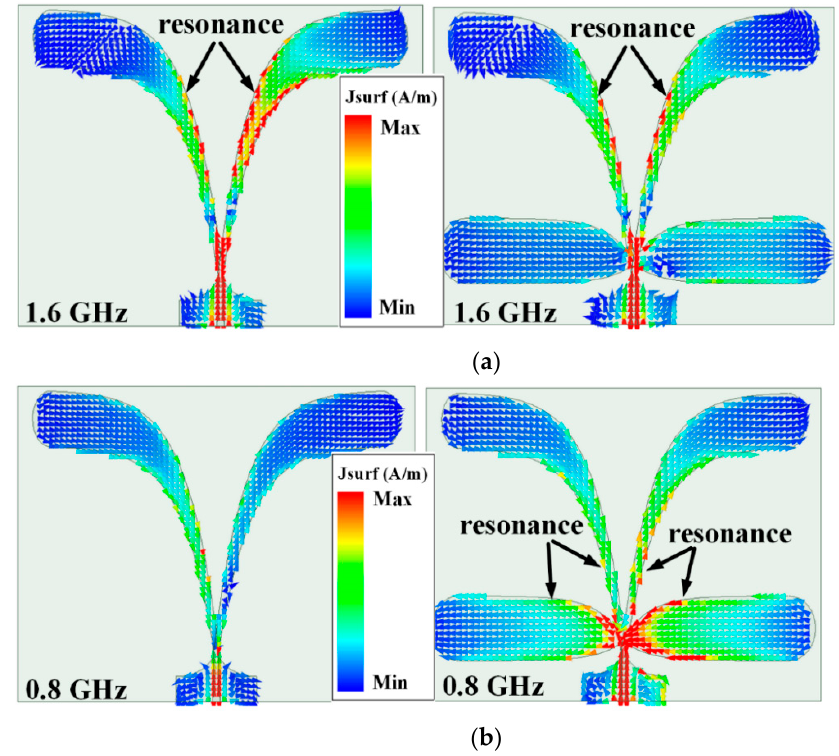
Figure 3. ( a ) Surface current distribution on the proposed antenna structure with/without addi- tional strip arms at the frequency of ( a ) 1.6 GHz, and ( b ) 0.8 GHz. Table 1. Final optimum parameter values of the proposed